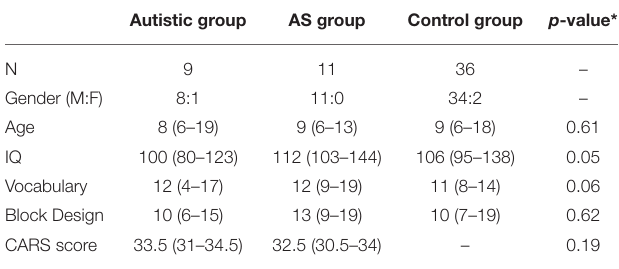
Table 3 . The upper tolerance limits, based on the